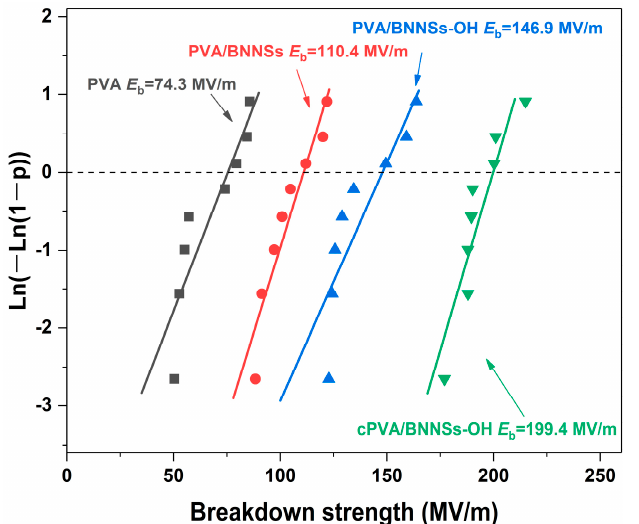
Figure 8. Weibull breakdown strength distributions of PVA, PVA/BNNSs, PVA/BNNSs-OH, and cPVA/BNNSs-OH fi lms.